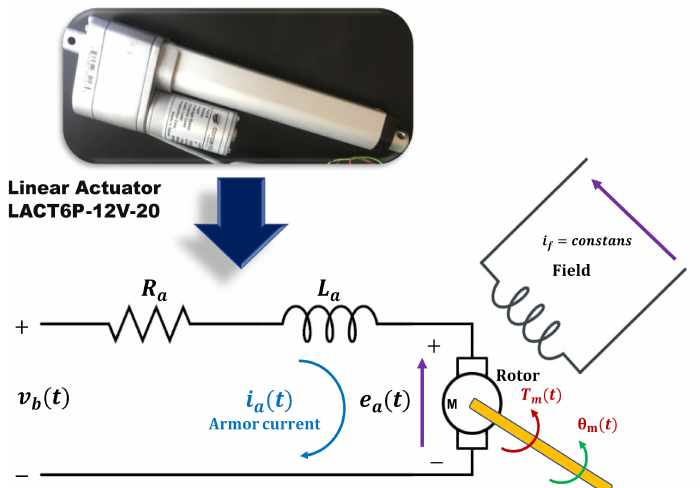
Figure 1. Scheme of linear electric actuator